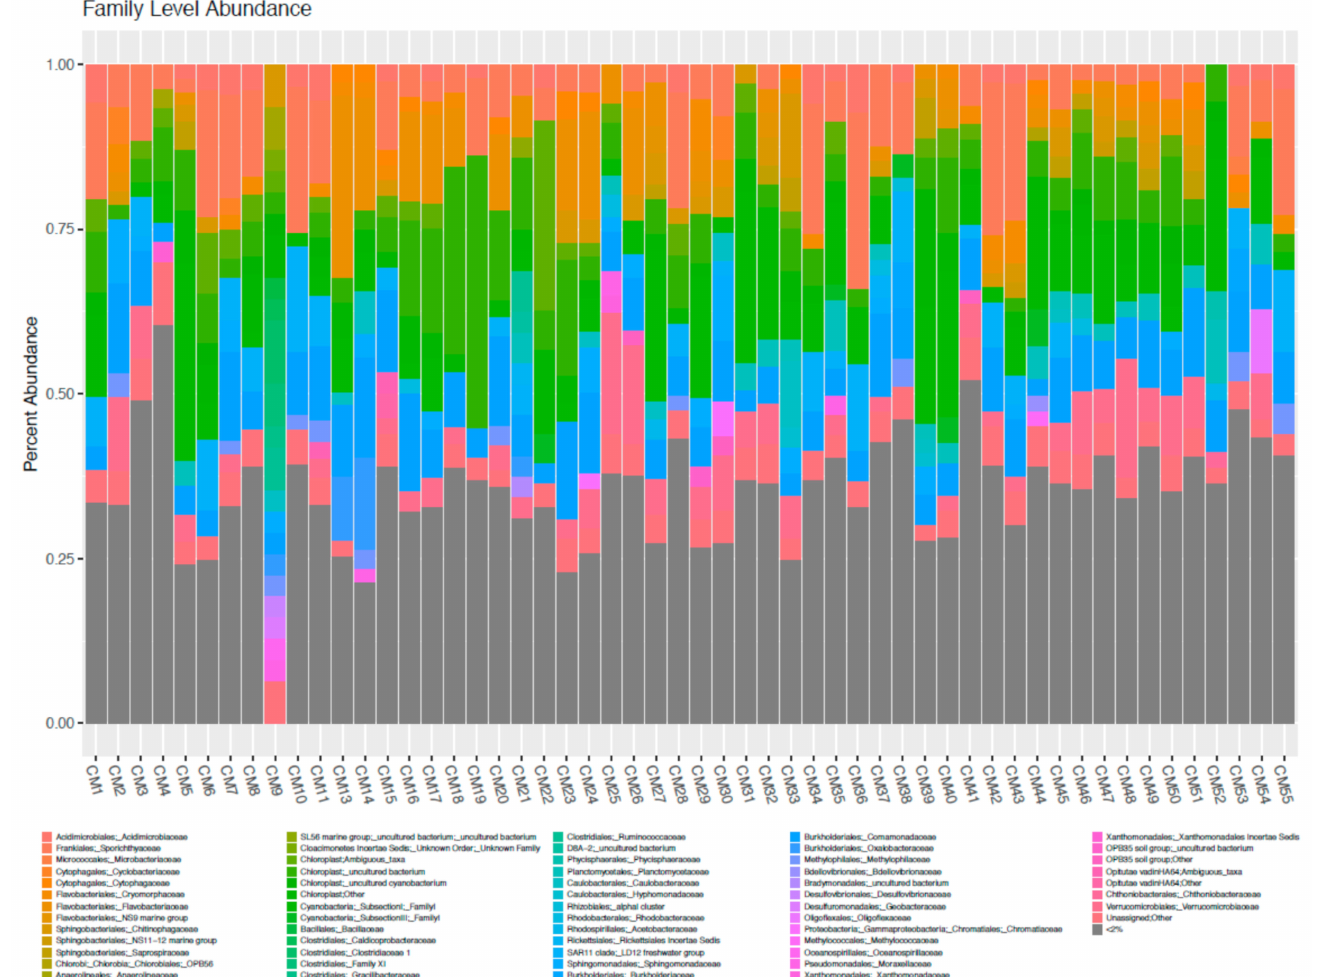
Figure 3. Alpha diversity at the Family level for OTU